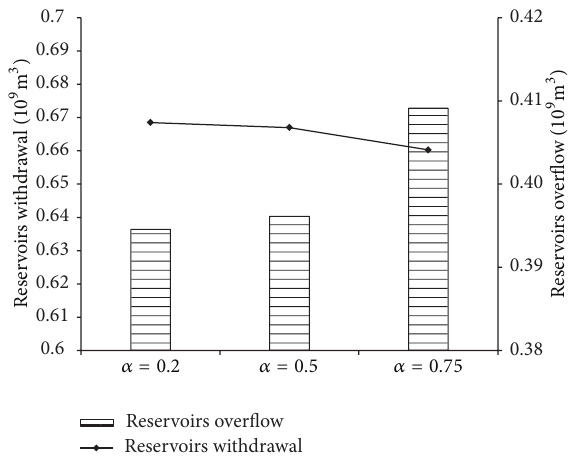
Figure 10: Reservoirs withdrawal and overflow under different 𝛼 - cut